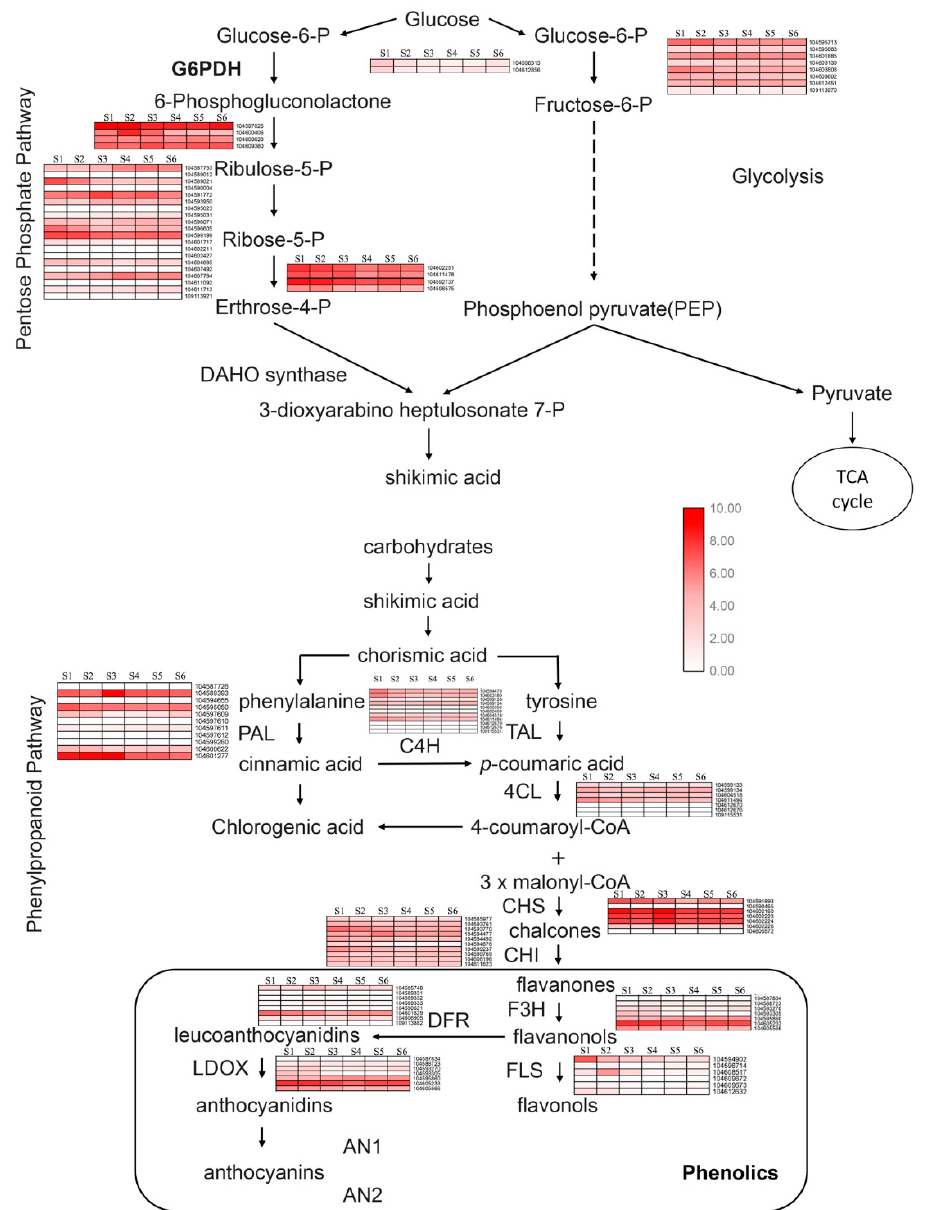
Figure 5. Expression patterns of expressed genes assigned to phenol biosynthesis in the S1, S2, S3, S4, S5, and S6 stage rhizome transcriptomes. Log-transformed expression values range from 0 to 10. Red gradations indicate up and downregulated transcripts.